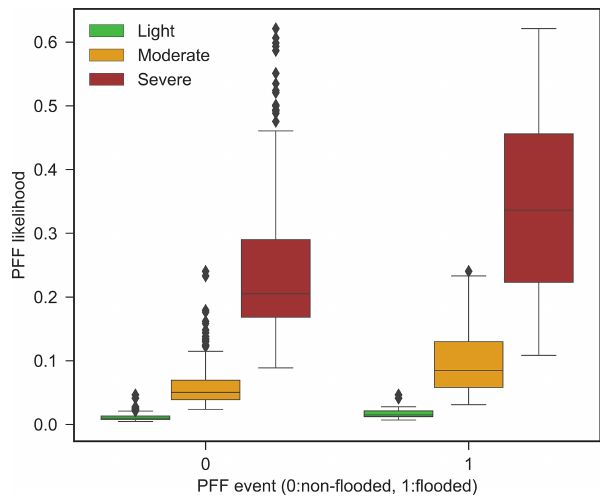
Figure 14. Distribution of flood likelihoods in reported versus non- reported